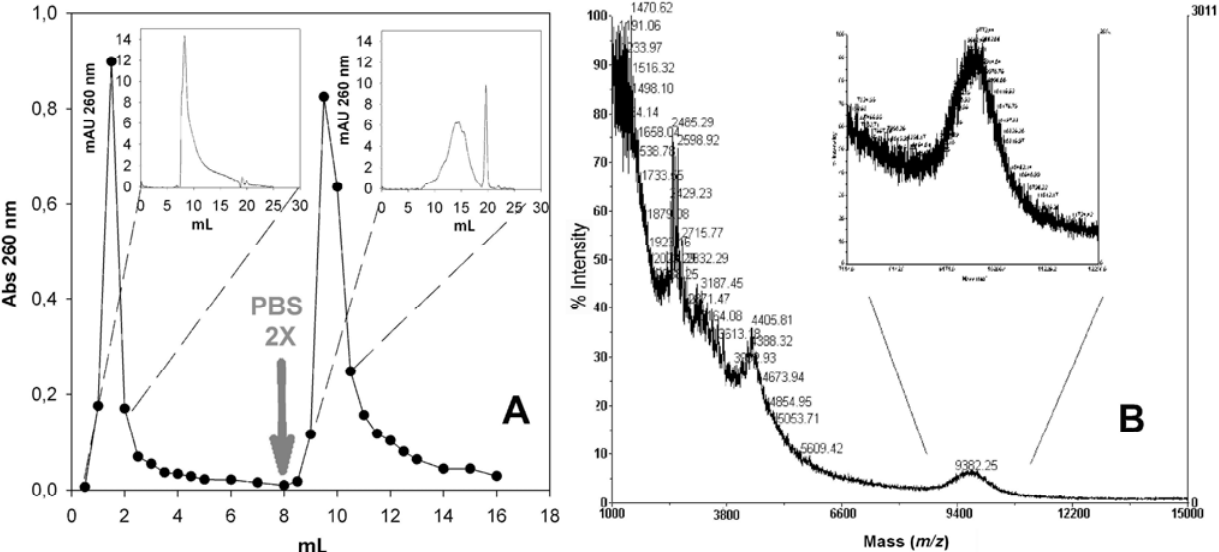
Figure 5. ( A ) NAP5 elution profile of Residue A of the HATU/DMAP reaction and FPLC analysis the two NAP5 peaks; ( B ) MALDI spectrum of the Sephadex G25 (NAP5) fraction eluted using H O as 2